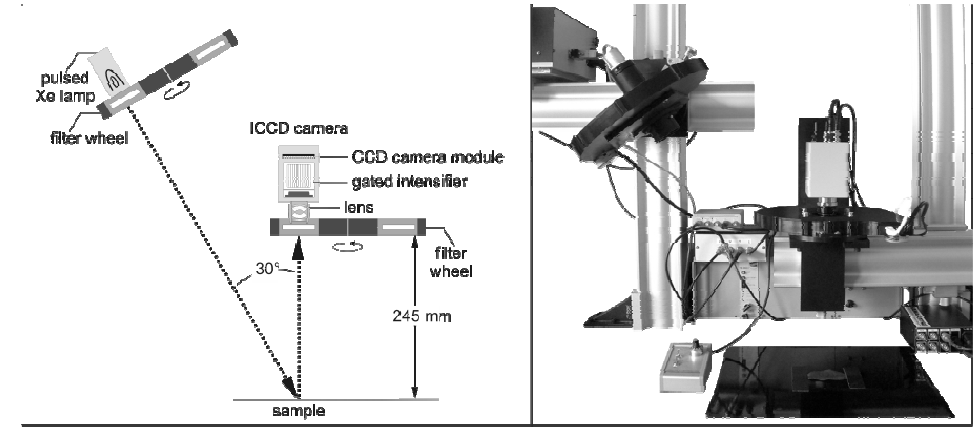
Figure 5. Setup of the Multi-color Fluorescence Imaging System for the measurement of leaf samples. (Left) Technical scheme of the assembling of the single components; (Right) Photograph of the sensor system.